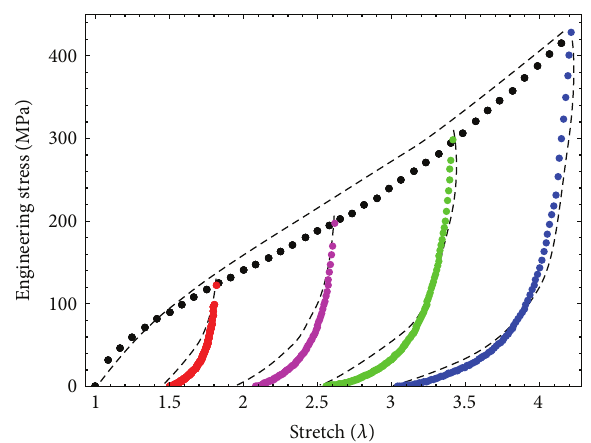
Figure 1: Experimental data collected from uniaxial tension cyclic loading-unloading tests for Monosyn